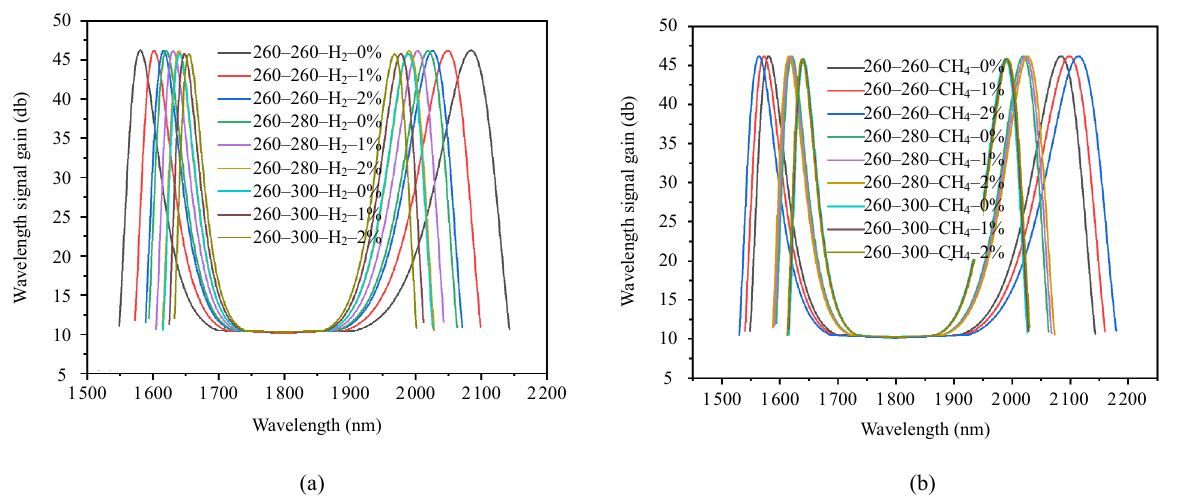
Fig. 3 Stokes and anti-Stokes gain spectrum curves with the variation of the hydrogen concentration (a) and Stokes and anti-Stokes gain spectrum curves with the variation of the methane concentration